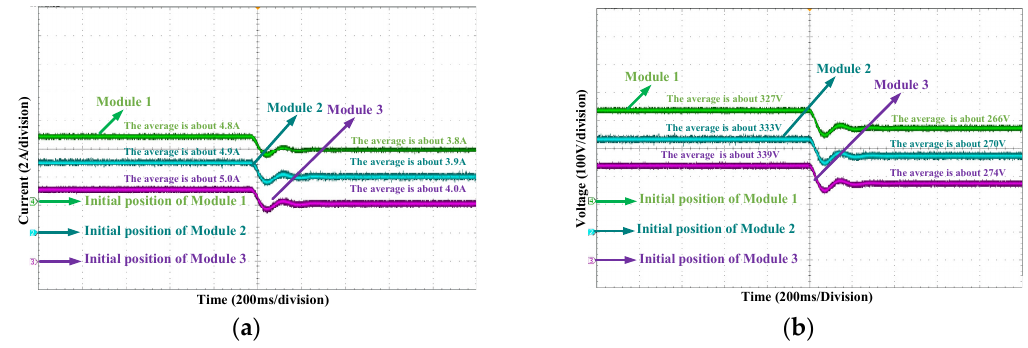
Figure 13. Experimental results of combined converter 1: ( a ) input current of the modules and ( b ) output voltage of the modules.